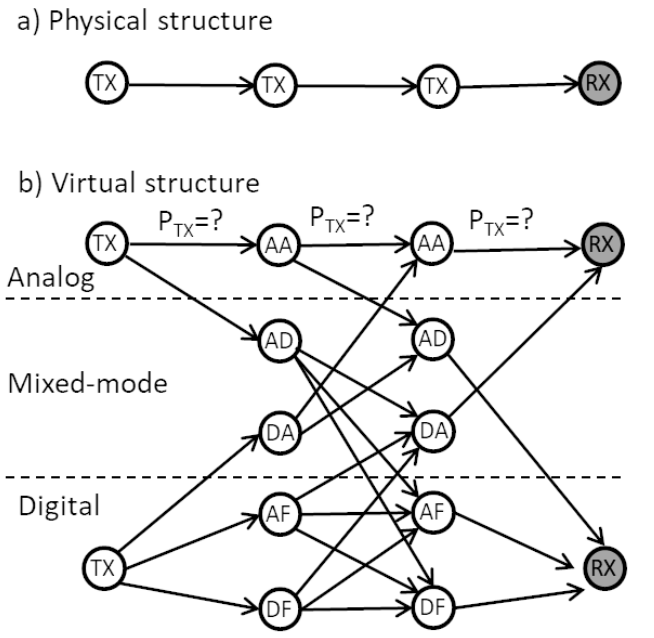
Figure 1. Diagram of the physical and virtual structure of the optimized subnetwork. AA: analog relay, AD: analog-digital relay, DA: digital-analog relay, AF: amplify and forward digital relay, DF: decode and forward digital